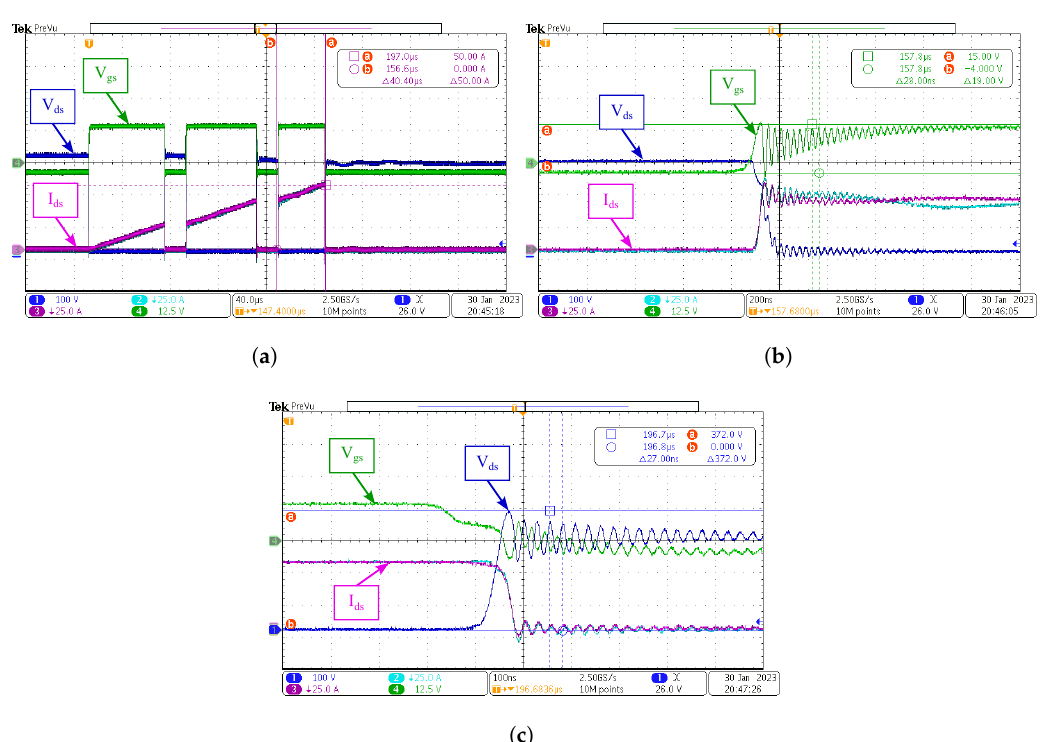
Figure 13. Extra 6 µ F Ceralink capacitance located through discrete MOSFETs connected in paral- lel, ( a ) Triple pulse test waveform, ( b ) Gate waveform.